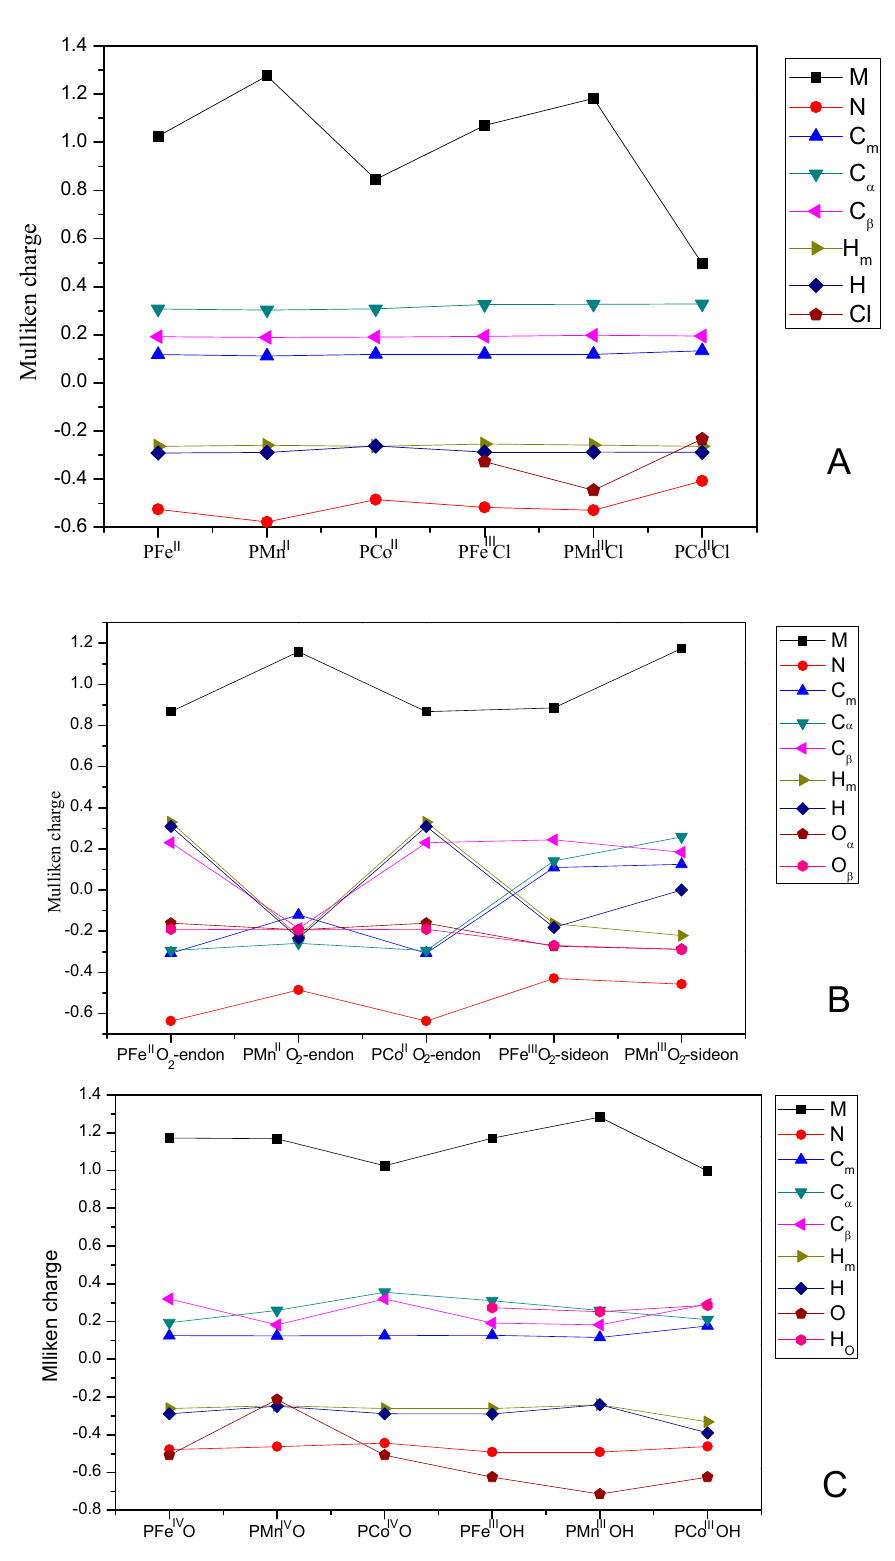
Figure 5. Mulliken charges on: ( A ) PM II / PM III Cl (M = Fe, Mn, and Co); ( B ) PM III -O 2 (M = Fe, Mn, and Co); and ( C ) PM IV = O / PM III OH (M = Fe, Mn, and Co). For all hydroxy species, O atoms have more negative charge than these high valent species (PM IV O). Indeed, PFe III OH was considered to combine with alkane radical in the OH radical